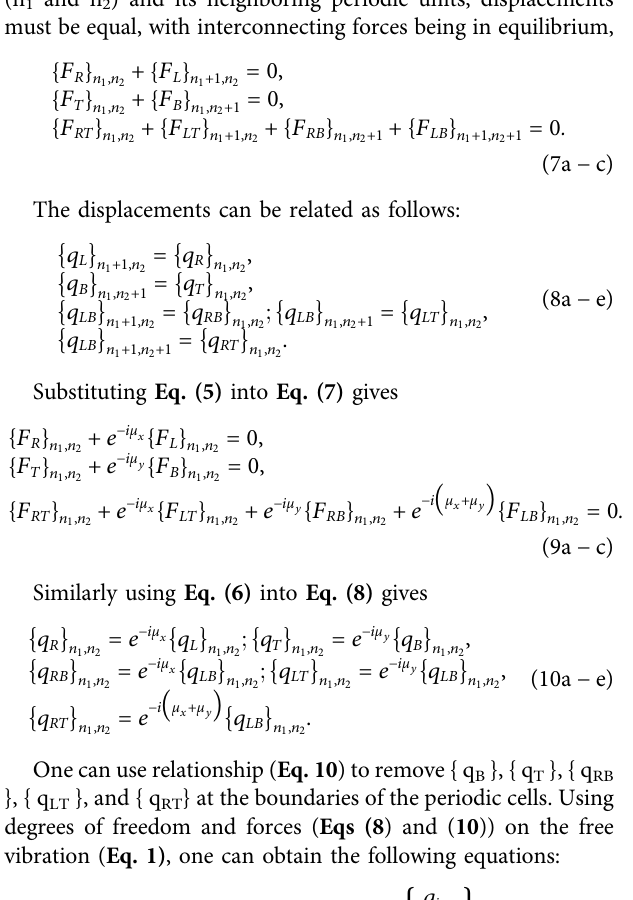
Frontiers in Mechanical Engineering |